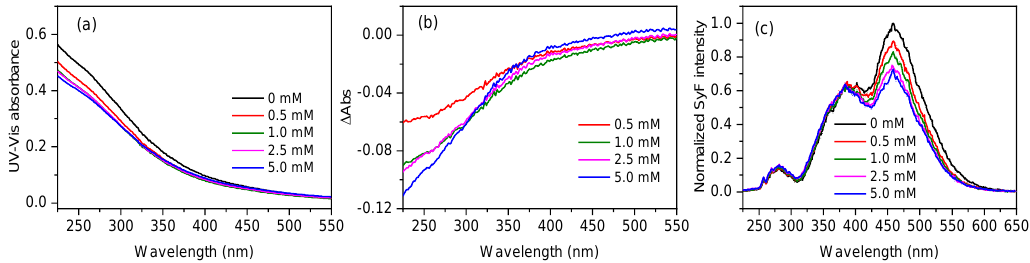
Figure 6. UV-Vis absorbance ( a ), changes in UV-Vis absorbance ( b ) and normalized (to highest peak) SyF spectra ( c ) of HA with increasing Ca(II) concentrations.